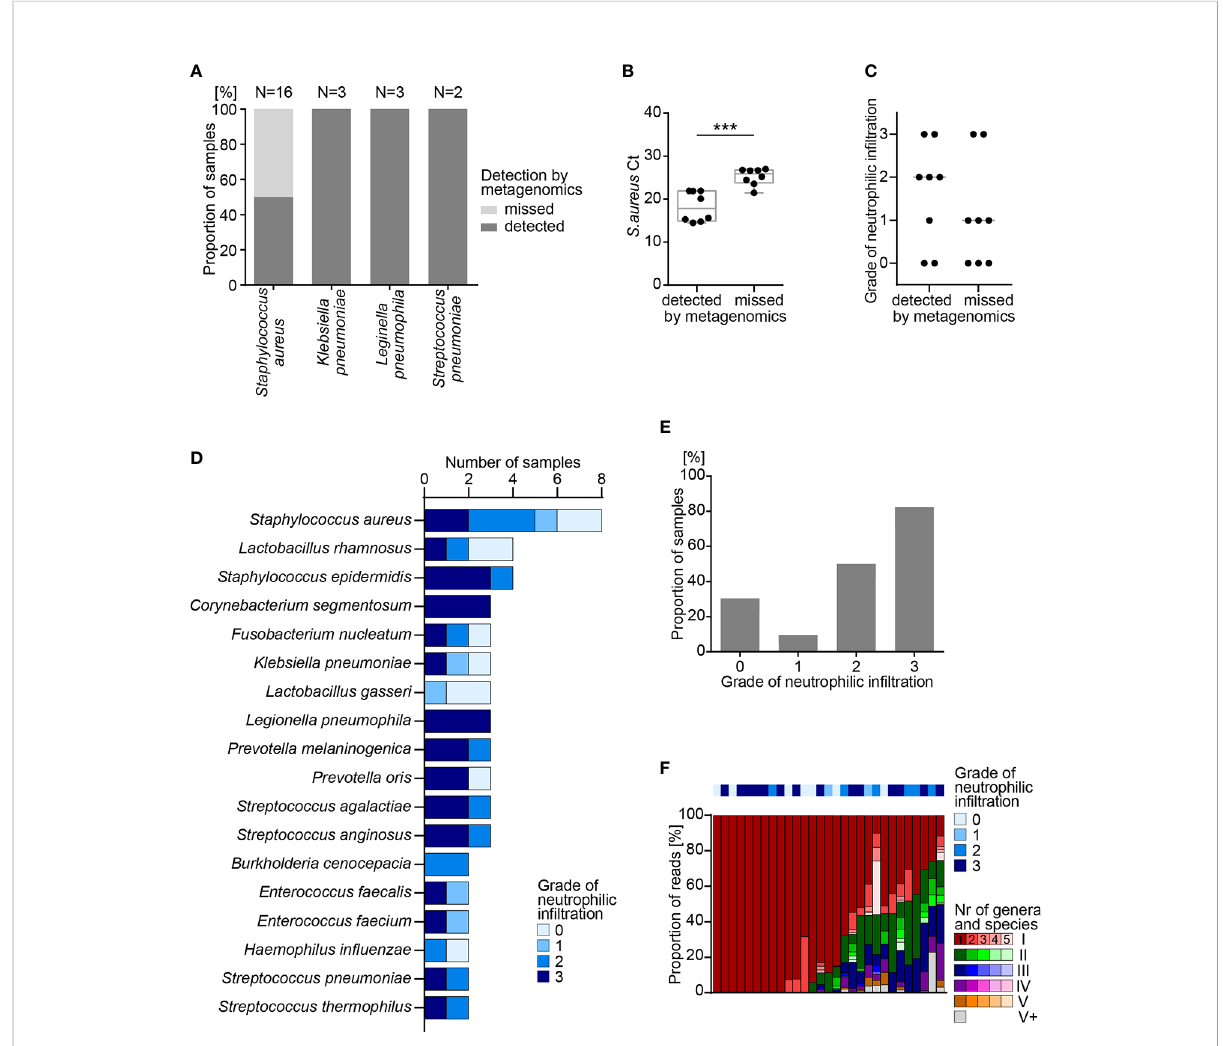
FIGURE 4 Metagenomics analysis of FFPE lung tissue samples. (A) Detection of bacterial pathogens in human FFPE lung tissue samples by quantitative PCR (qPCR) and by metagenomics analysis. (B) Detection of S. aureus by qPCR and by metagenomics analysis in 16 samples. Box shows range from fi rst to third quartile and median, whiskers display minimum and maximum. Statistical analysis: T-test; ***, p<0.001. (C) Grade of neutrophilic in fi ltration in human FFPE lung autopsy tissues. (D) Number of samples positive for the indicated species, as determined by metagenomics analysis. (E) Fraction of samples with one or more bacterial species identi fi ed by metagenomics analysis, sorted by grade of neutrophilic in fi ltration. Statistical analysis: c -square-test; ****, p<0.0001. (F) Fraction of reads representing individual species for each sample presented in E. Colors (e.g. red, green, blue, purple, orange) represent individual genera and shades of the same color (e.g. dark red, red, light red, rose, faint rose) represent individual species of the same genus, sorted from most frequent to least frequent. According to their rank of abundance within an individual sample, genus and species are highlighted by colors and shades: red represents the most frequent genus; green the 2 nd , blue the 3 rd , purple the 4 th and orange the 5 th most frequent genus. Grey represents all genera with rank 6 or higher. FFPE, formalin- fi xed paraf fi n- embedded; Ct, cycle